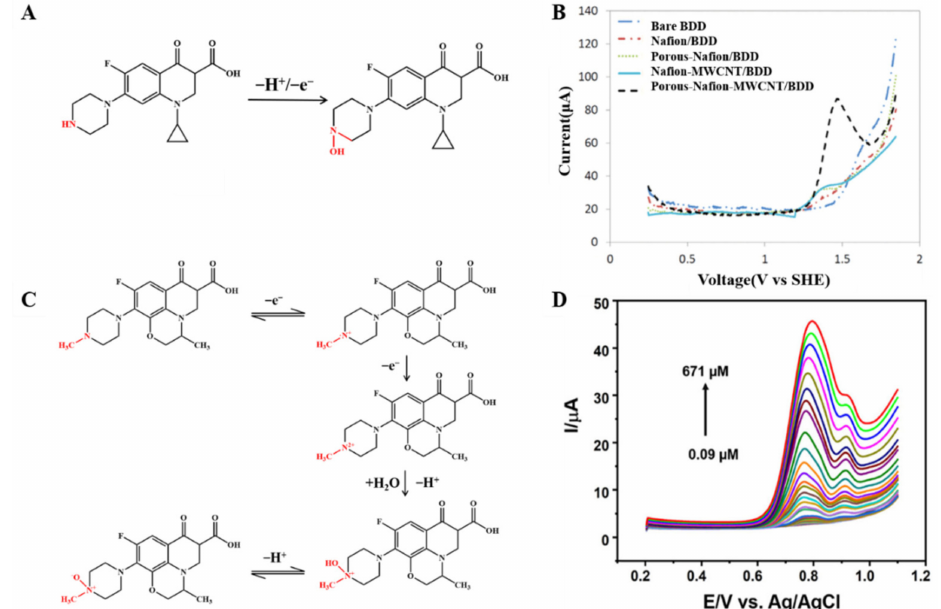
Figure 5. Mechanism for the electrochemical levoxidation of ciprofloxacin ( A ) and ofloxacin ( C ). ( B ) DPV curves of 50 µ M ciprofloxacin on BDD, Nafion/BDD, porous-Nafion/BDD, Nafion- MWCNT/BDD, and porous-Nafion-MWCNT/BDD electrodes in 0.1 M KH 2 PO 4 solution (pH = 4.50). Adapted with permission from Ref. [67]. Copyright 2016 ACS. ( D ) DPV response was obtained for Ag/AgVO 3 /N-rGO/SPCE by linear addition of levofloxacin in the N 2 environment. Adapted with permission from Ref. [74]. Copyright 2021